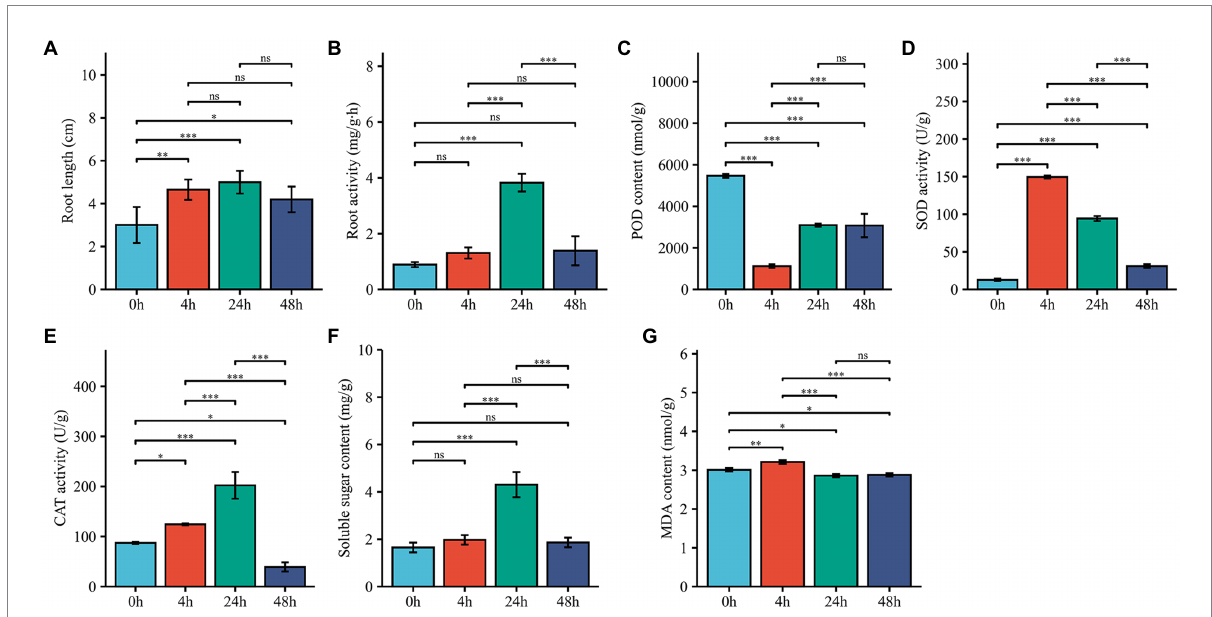
FIGURE 1 Effects of Al treatment on physiological characteristics. (A–G) Changes in root length, root activity, POD activity, SOD activity, CAT activity, SS content and MDA contents in root samples harvested from plants treated for 0, 4, 24, and 48 h. 0 h represents control samples, and 4, 24, and 48 h represent 4-h, 24-h, and 48-h Al stress-treated samples. The error bar represent the SDs across 3 different biological duplicates ( n = 3). The asterisks represent significant differences in acid Al-treated samples compared with the controls (* p < 0.05; ** p < 0.01; *** p <